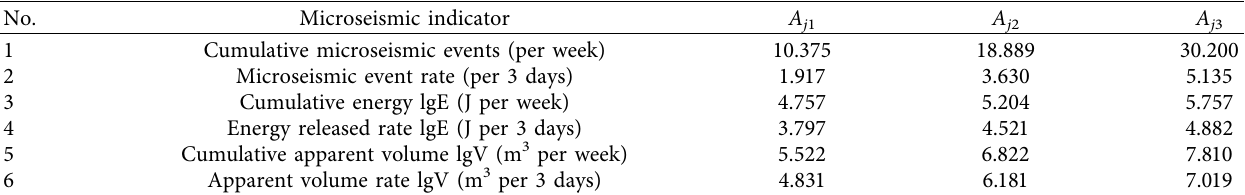
Table 1: Eigenvalues of microseismic indicators for rock burst of different intensities.